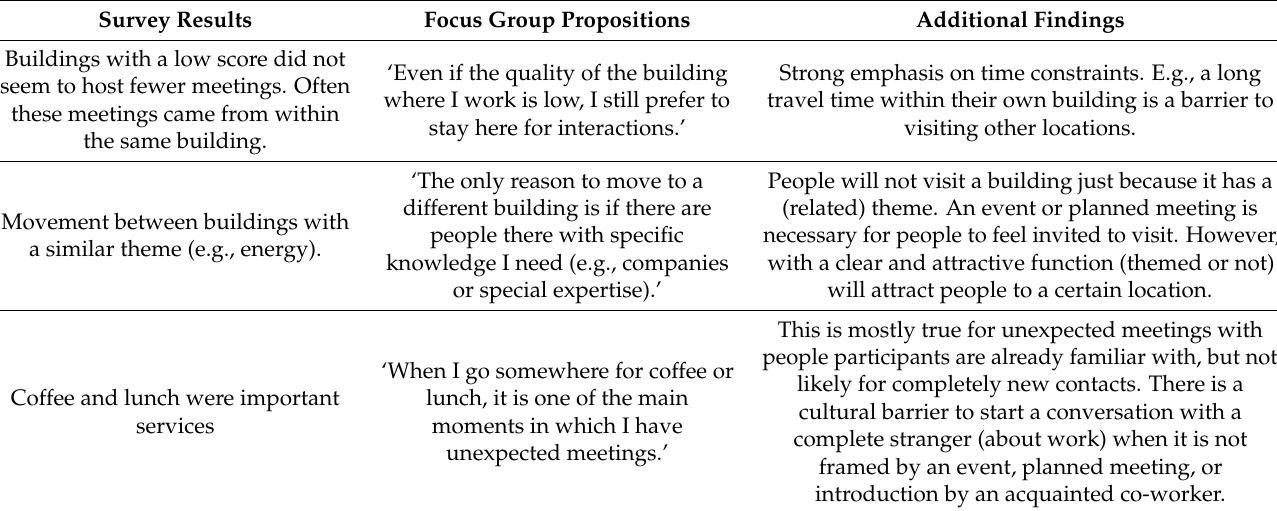
Table 2. An overview of